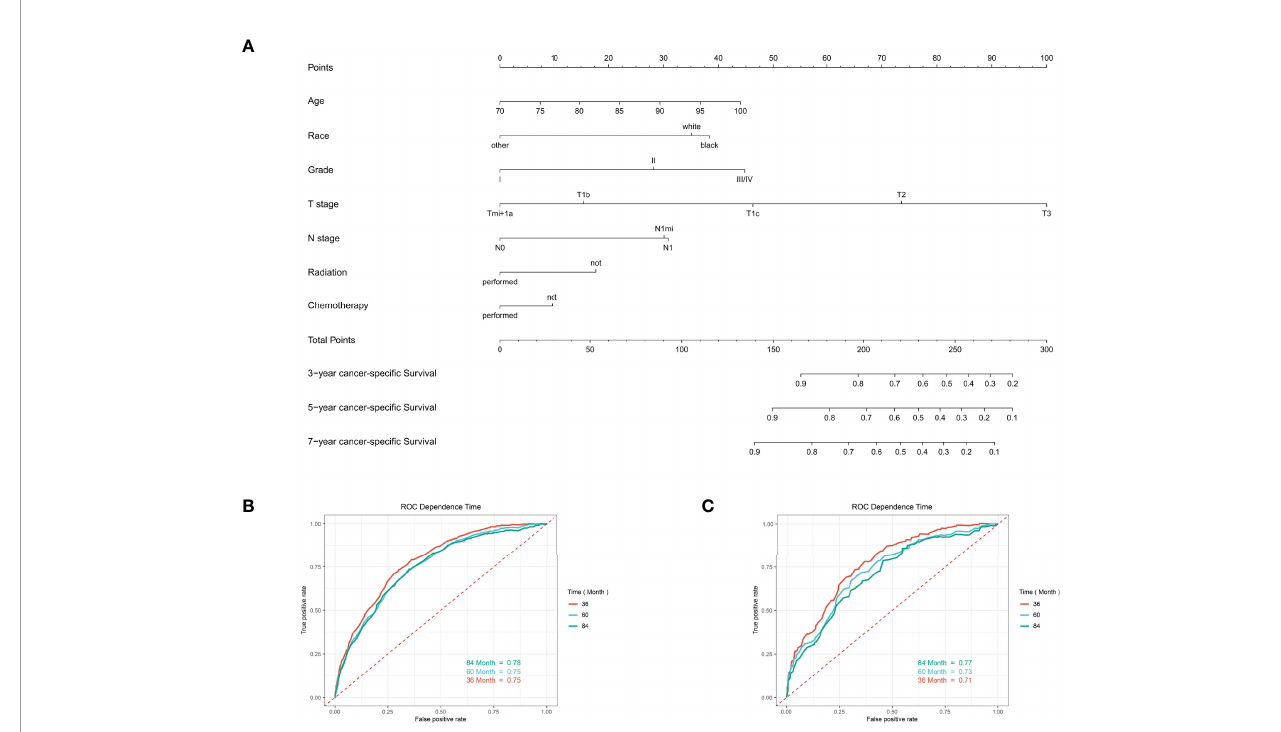
FIGURE 8 | The predictive model for predicting the long-term cancer-speci fi c survival probability in women aged 70 years or older with primary operable, triple- negative breast cancer in the training cohort. (A) Nomogram for predicting the 3-, 5-, and 7- year CSS for elderly primary operable TNBC patients. (B) The receiver operating characteristics (ROC) curve and area under the ROC curve (AUC) in the training cohort. (C) The receiver operating characteristics (ROC) curve and area under the ROC curve (AUC) validating cohort.